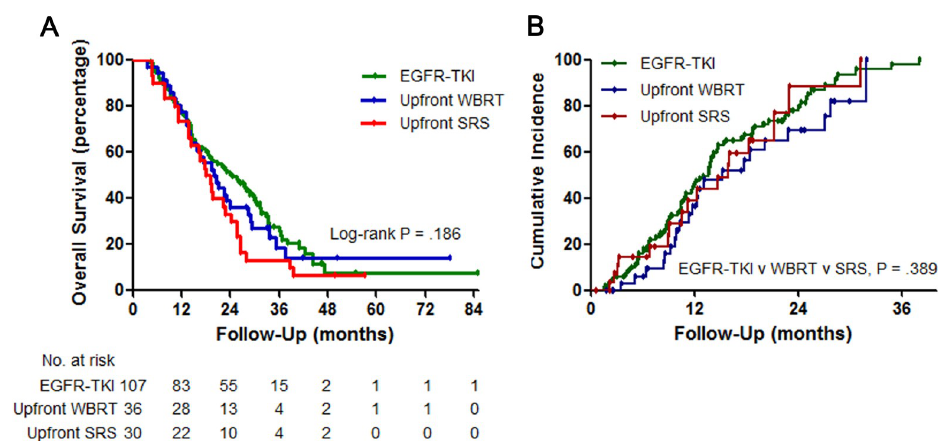
Fig 1. (A) Kaplan–Meier analysis comparing overall survival. Patients treated with epidermal growth factor receptor- tyrosine kinase inhibitor (EGFR-TKI), upfront whole-brain radiotherapy (WBRT) and upfront stereotactic radiosurgery (SRS). (B) Cumulative incidence of intracranial progression. Patients treated with EGFR-TKI, upfront WBRT and upfront